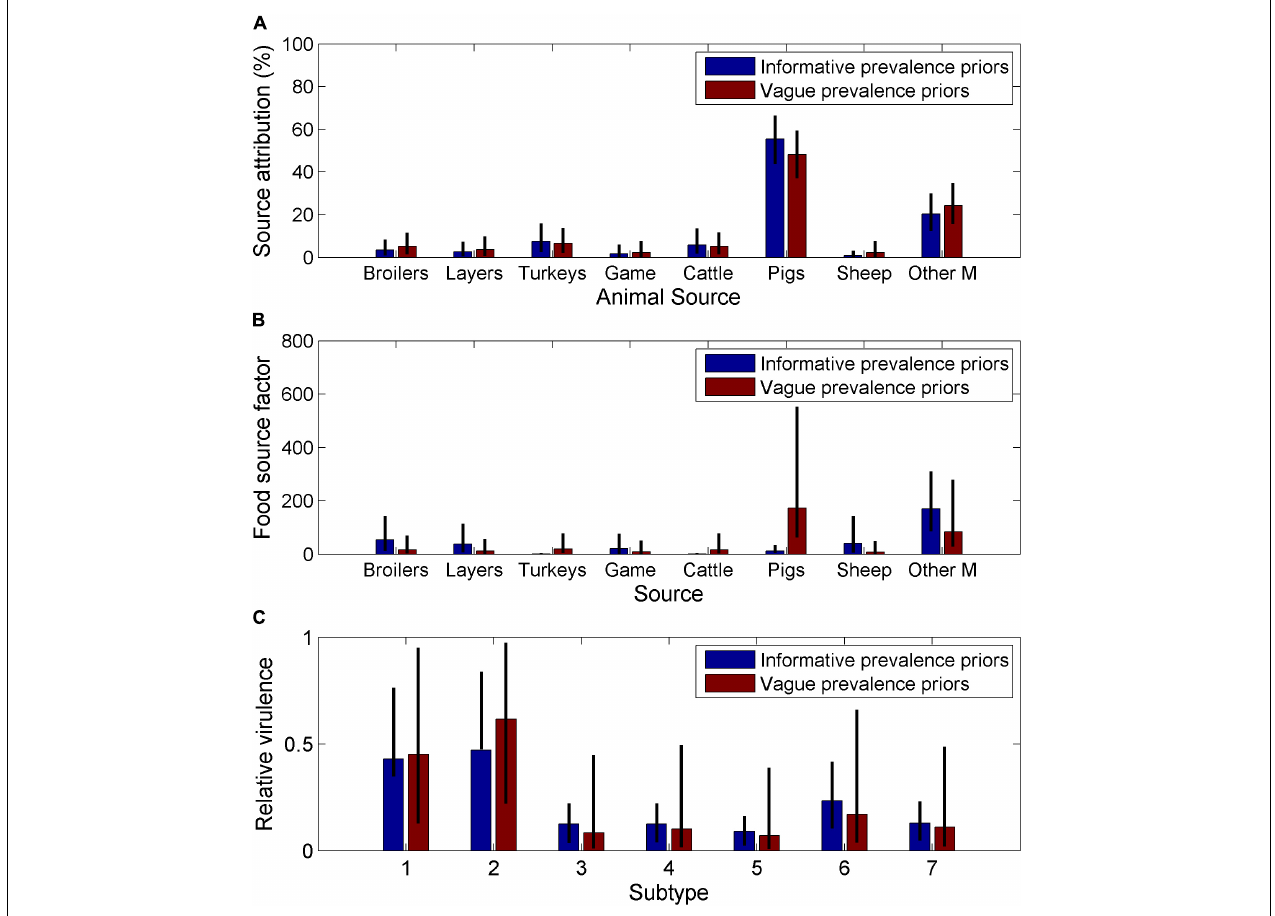
FIGURE 3 | Comparison of estimates from a Bayesian source attribution model for England and Wales when using informative and non-informative priors on (A) the source attribution estimates for each animal source (B) animal source dependent factors, which is a summary measure of the ability of the source to act as a vehicle for human infection, and will depend on human consumption/contact with the animal source, and the environment provided for the bacteria through storage/preparation and (C) relative virulence by subtype, which is a measure of the relative ability of the subtype to cause human disease based on a combination of pathogenicity, survivability and virulence (Other M = other mammals, Game = game birds), the seven different SNP10 types were arbitrarily labelled